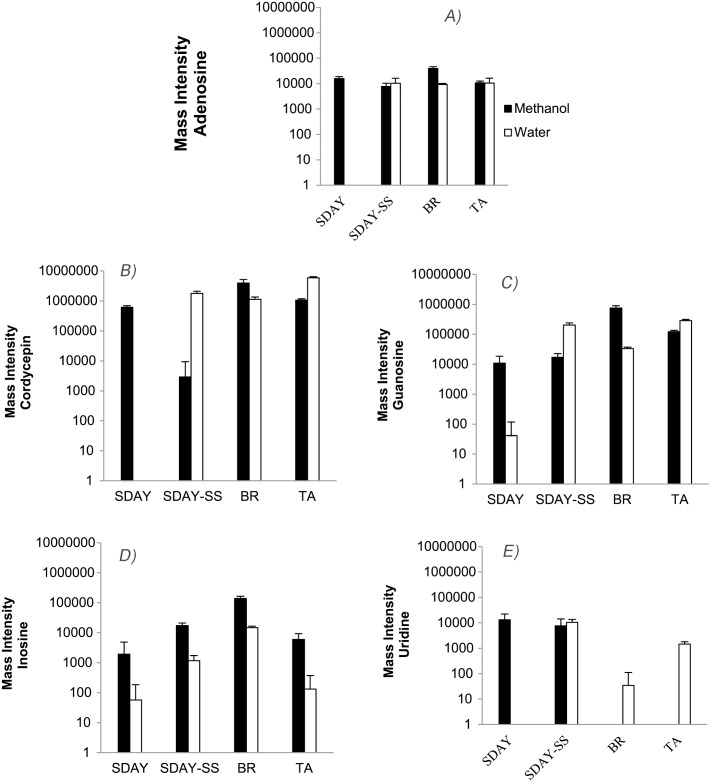
Mass intensities of nucleosides.A) cordycepin, B) adenosine, C) inosine, D) guanosine, and E) uridine extracted from mycelium of C. nidus grown on different culture media. Methanol (black) and water (white) extracts. Statistical significance for alpha = 0.05: a. 9.26 10−9, b. 1.32 10−7, c. 5.83 10−11, d. 4.11 10−11, e. 3.72 10−3, f. 2.85 10−3, g. 1.64 10−14, h. 2.39 10−12, i. 1.44 10−14.